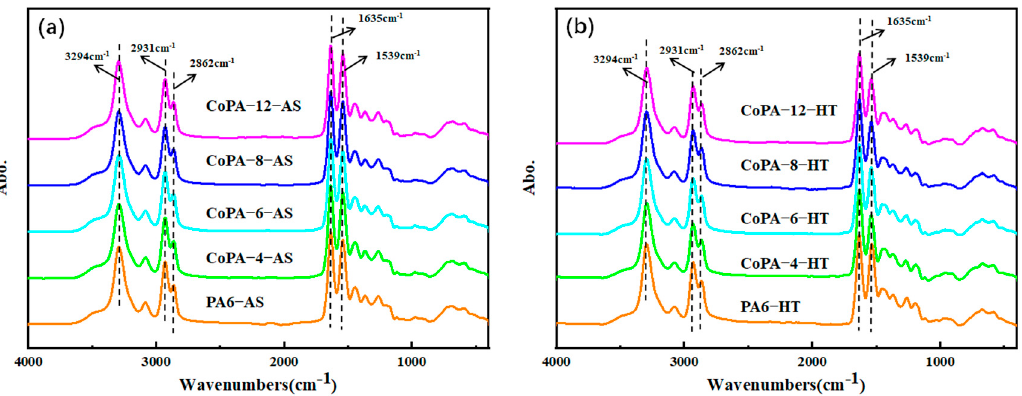
Figure 4. Typical attenuated in-site total reflection Fourier transform infrared spectra for as-spun ( a ) and HT ( b ) PA6 and CoPAs.